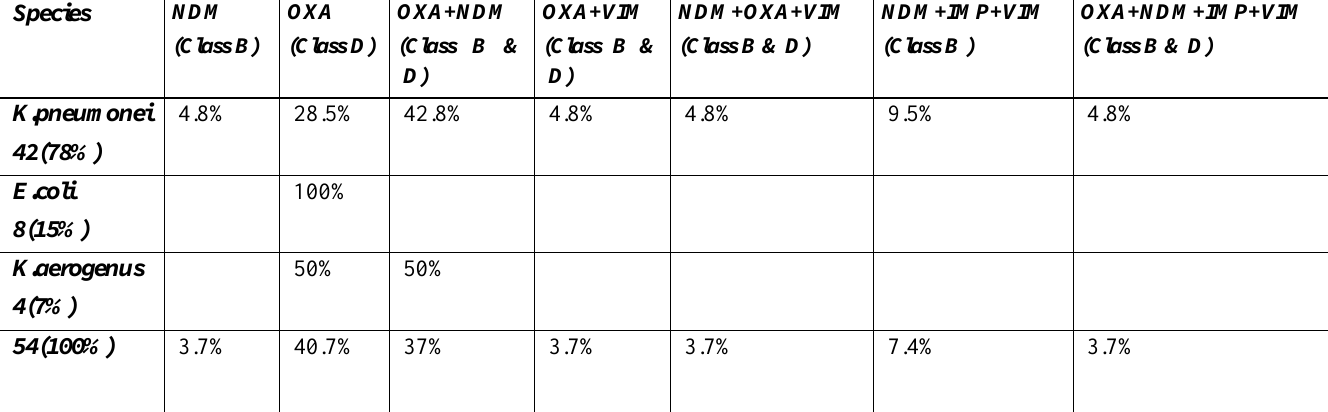
Table 1. The distribution of different carbapenemases genes in the study.